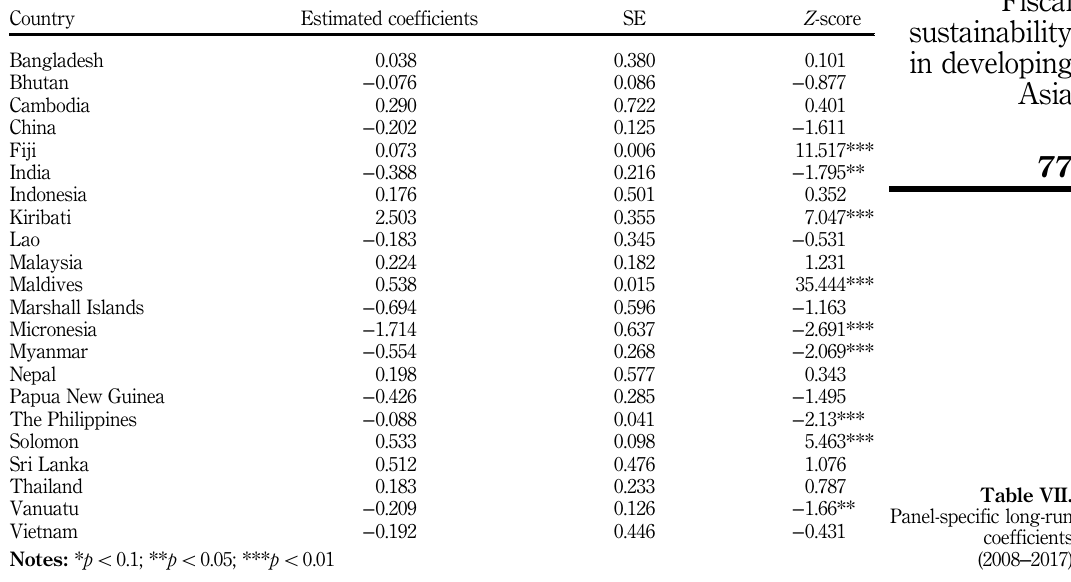
Table VII. Panel-specific